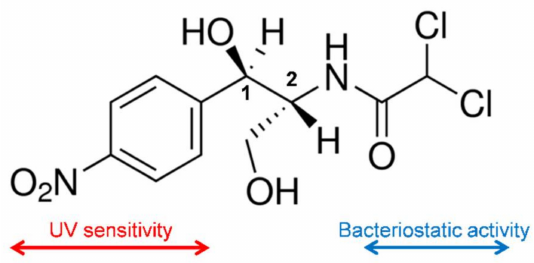
Figure 1. Chemical structure of chloramphenicol